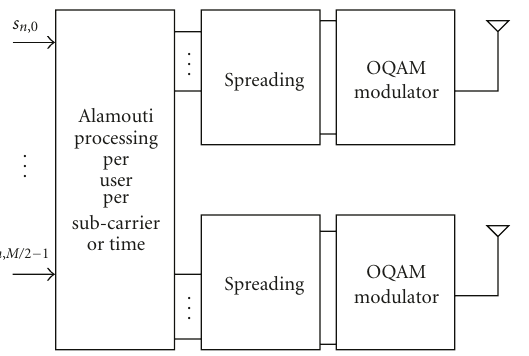
Figure 5: An Alamouti CDMA-OFDM/OQAM transmitter.